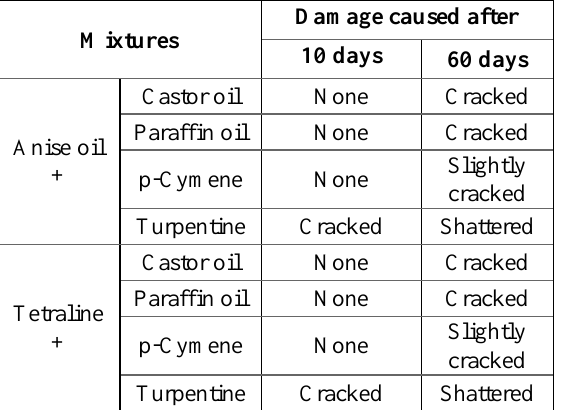
Table 4. Damage caused to pieces in mixtures with matched RI to PMMA in 10 and 60 days